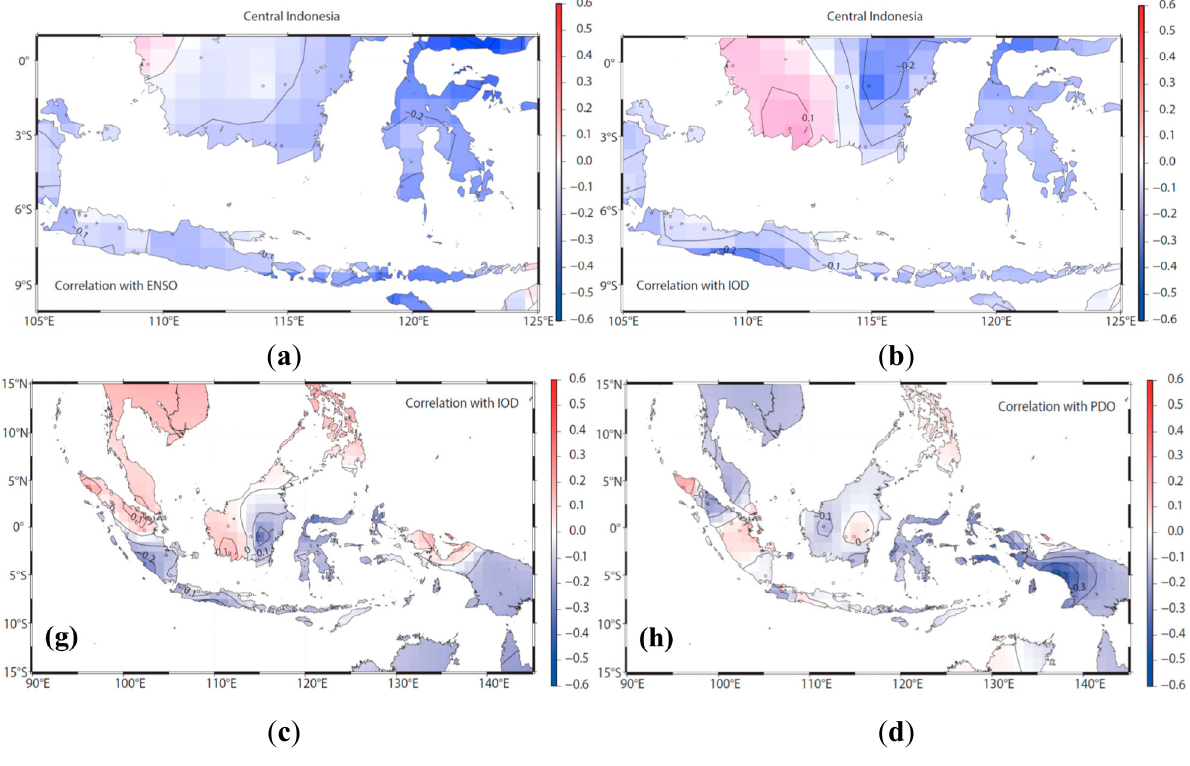
Figure 6. Spatial correlations between rainfall and the ( a ) MEI; ( b ) the DMI; ( c ) NINO.WEST and ( d ) the PDO in central